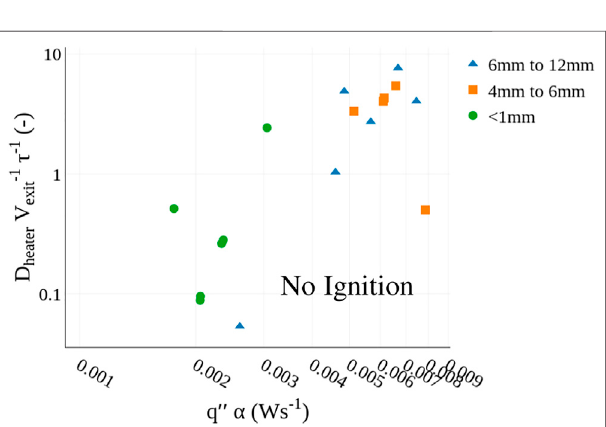
FIGURE 9 | Comparison of non-dimensional chemical and fl ow timescale (for the igniting cases) as a function of heat fl ux time and thermal diffusivity. Conditions where ignition and non-ignition are anticipated are